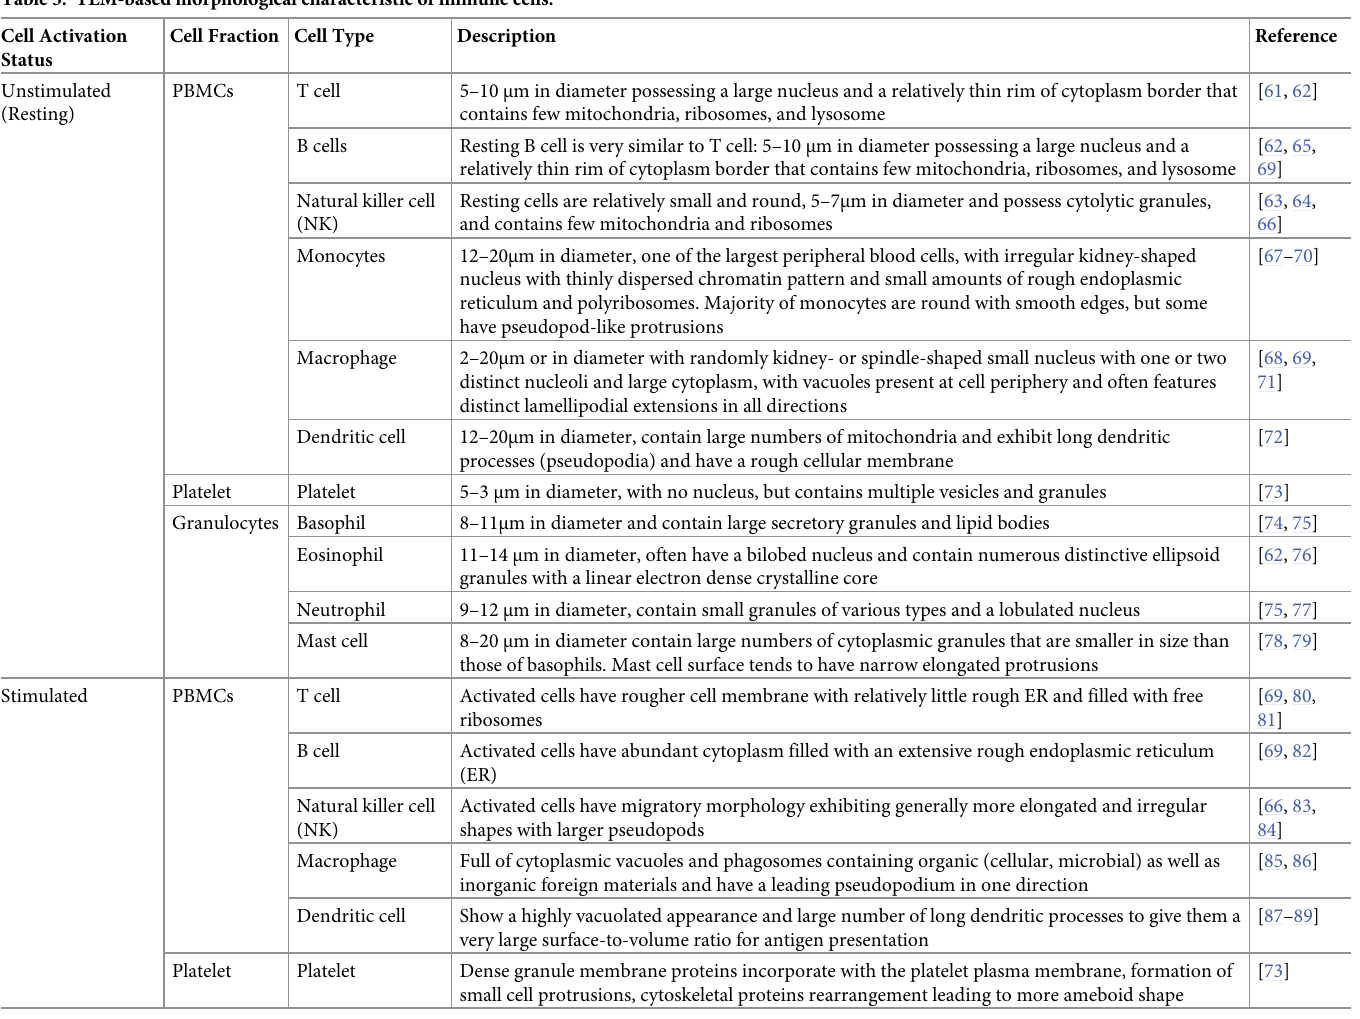
Table 3. TEM-based morphological characteristic of immune